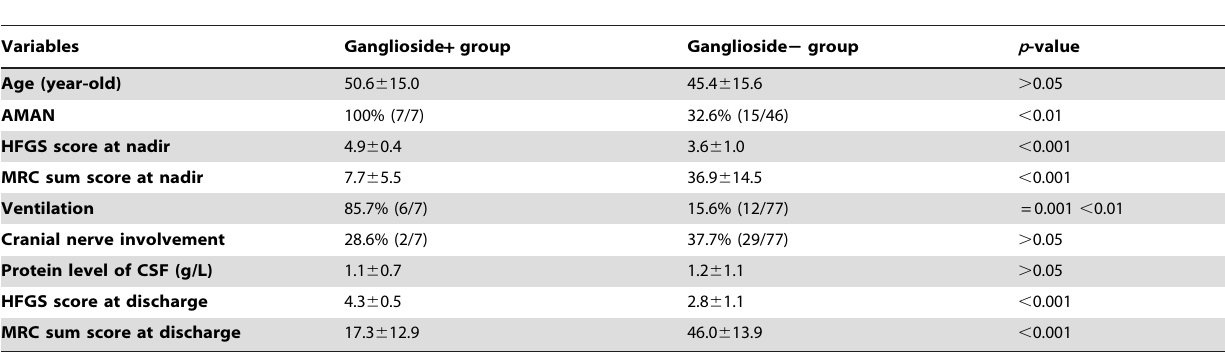
GBS: Guillain-Barre´ syndrome; AMAN: acute motor axonal neuropathy; CSF: cerebrospinal fluid; HFGS: the Hughes Functional Grading Scale; MRC: the Medical Research Council.